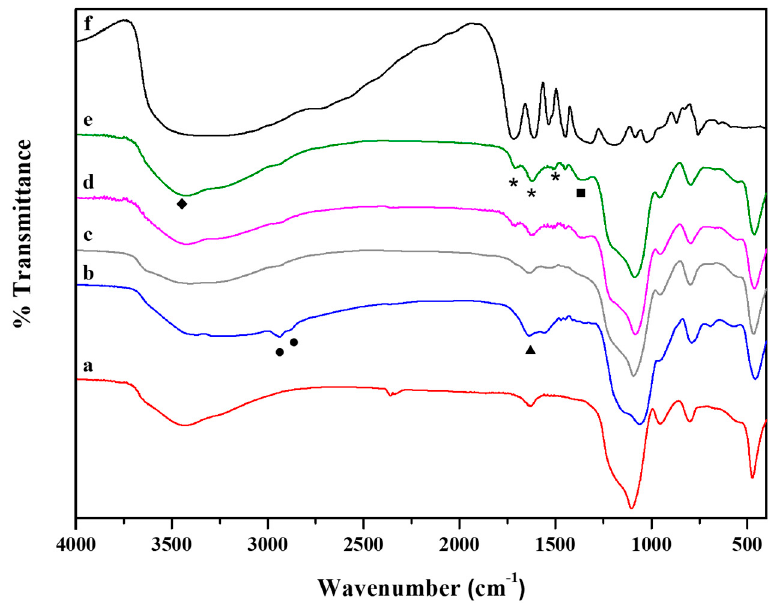
Figure 3. FT-IR spectra of: SiO 2 ( a ), 30TA-SiO 2 ( b ), 60TA-SiO 2 ( c ), 120TA-SiO 2 ( d ) and 150TA-SiO 2 NPs ( e ). For the sake of comparison the spectrum of pure TA ( f ) is reported, the highest in the graph.